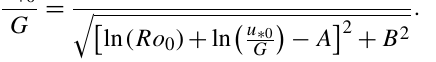
Figure 5. Normalized boundary layer depth z i predicted by limited- length-scale k – ε model extended to unstable surface layer stratifi- cation, as a function of the three Rossby